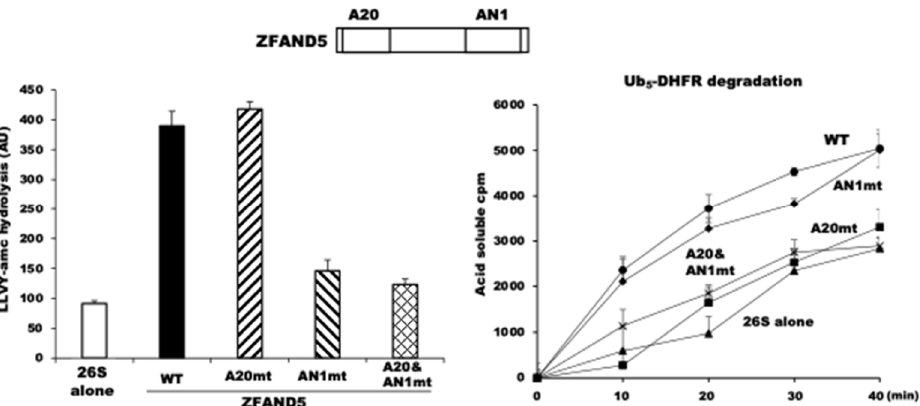
Figure 4. ZFAND5 directly activates purified 26S proteasomes and increases their ability to hydrolyze peptides and ubiquitin conjugates. (Left Panel) ZFAND5 stimulates the peptidase activity of 26S proteasomes. This activation is dependent on ZFAND5’s C-terminal AN1 domain. (Right Panel) ZFAND5 enhances also degradation of ubiquitinated 32 P-dehydrofolate reductase. Its A20 domain is essential for the increased degradation of ubiquitinated proteins.